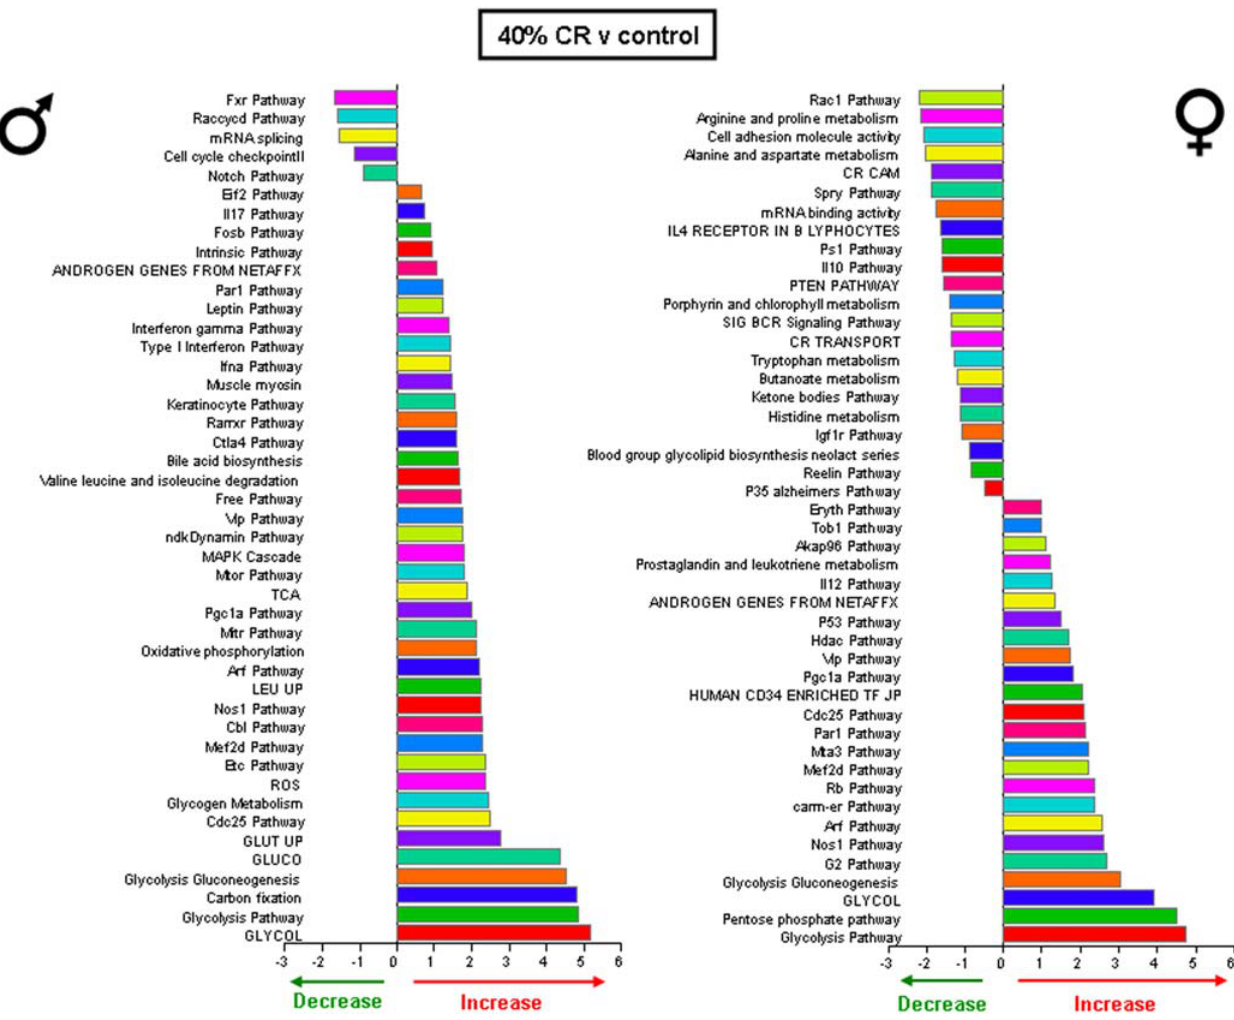
Figure 10. Significant gene pathway changes in the hippocampi of male and female rats maintained on a 40% CR diet. Significantly altered genes in the male and female hippocampi from the different dietary regimes were clustered into functional gene pathways. In the hippocampi from male rats on the 40% CR diet, there were 45 significantly altered gene pathways, of which 5 pathways were significantly down- regulated and 40 pathways were significantly up-regulated, compared to gene pathways in hippocampi from male control rats. Interestingly, the hippocampi from female rats on the 40% CR diet showed a very different functional gene pathway pattern as there were 46 significantly altered pathways, of which 22 were significantly down-regulated and 24 were significantly up-regulated, compared to gene pathways in hippocampi from control female rats.